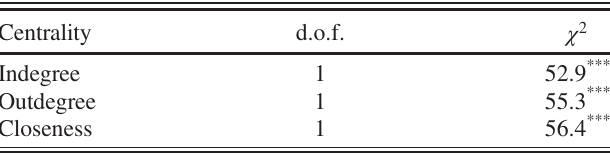
TABLE VI. Summary of the likelihood ratio test performed for the multiple logistic regression models with a student ’ s final grade considered as additional predictor (persistence ∼ centrality þ grade) when compared to the simple models (persistence ∼ centrality). Significant adjusted p values are marked with an asterisk.